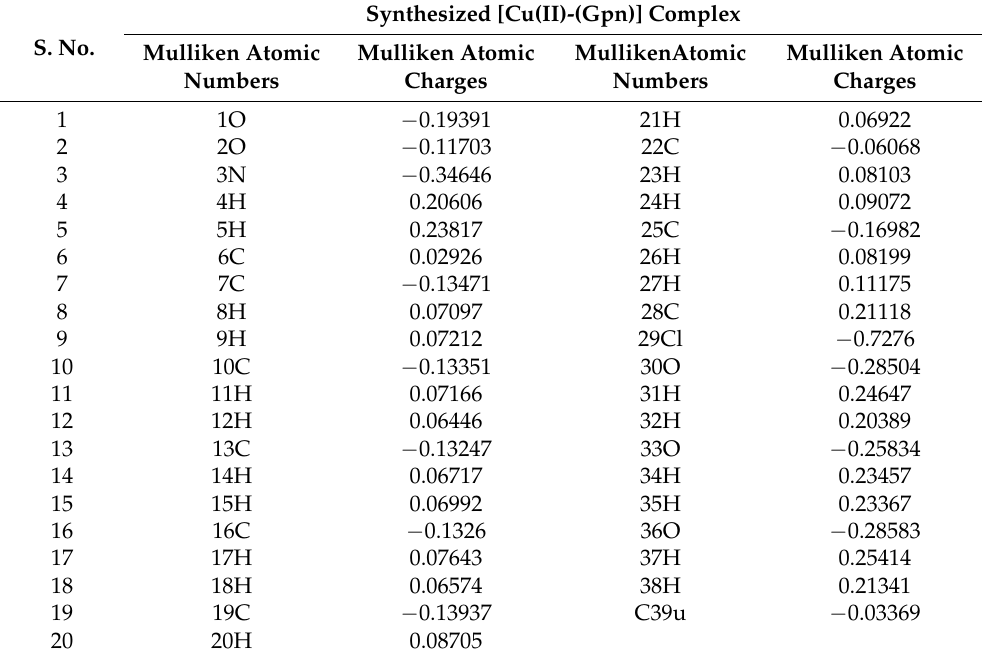
Table 7. The Mulliken atomic charges of the metal complex [Cu(II)–(Gpn)] atoms.